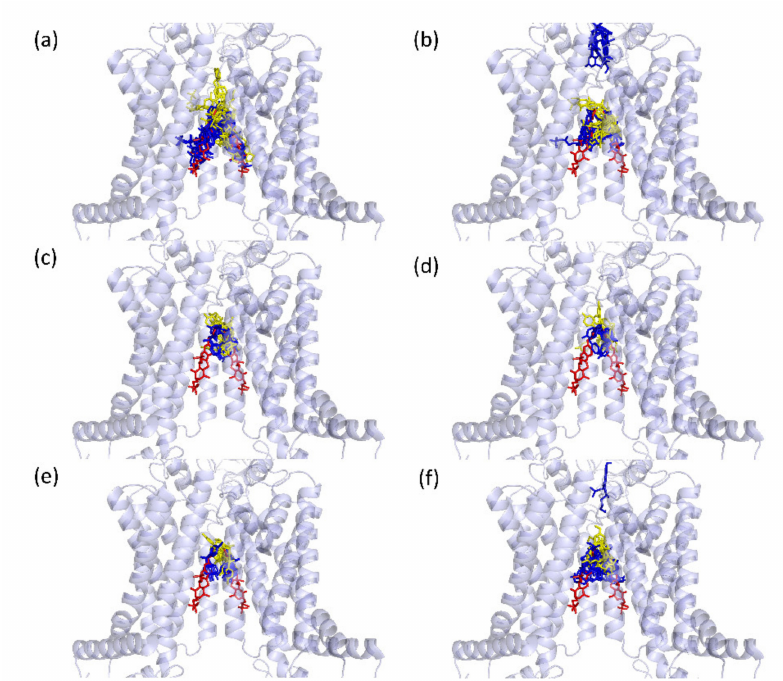
Figure 3. All 10 predicted docking positions for ( a ) MZ29 (known BCRP inhibitor), ( b ) Ko143 (known BCRP inhibitor), ( c ) BPA, ( d ) BPF, ( e ) BPS, and ( f ) MZ40 (known poor BCRP inhibitor) in the protein structure of inhibitor-bound BCRP (Protein Data Bank ID: 6 ETI). Red = MZ29 previously reported position. Blue = predicted docking sites by AutoDockFR. Yellow = predicted docking sites by